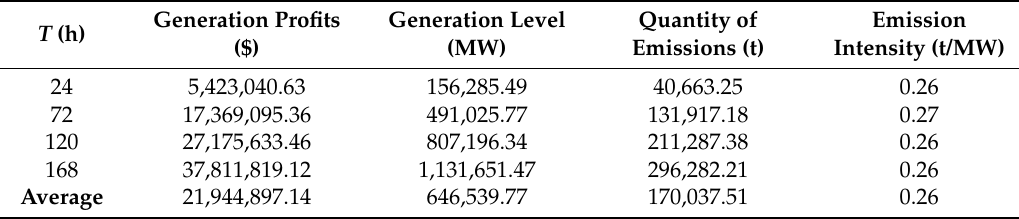
Table 3. Total generation profits, total generation level, the quantity of total emissions, and emission intensity under the proposed carbon-tax policy.